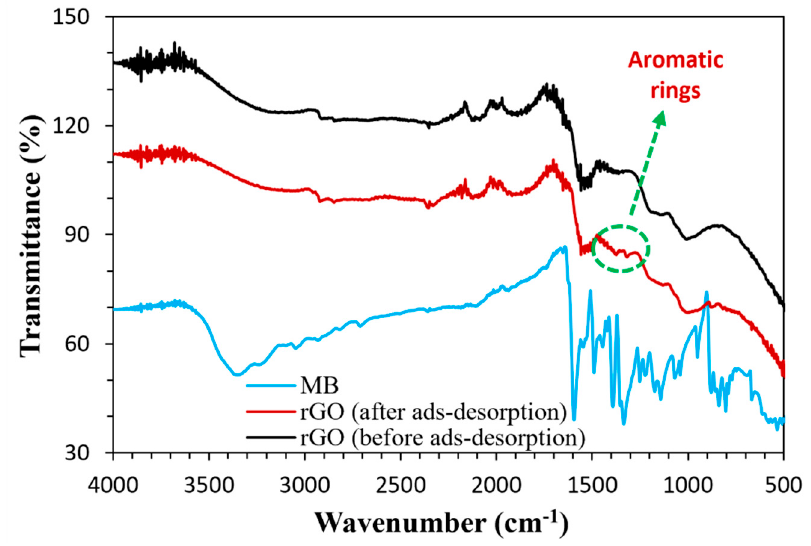
Figure 17. Recycling performance of rGO for capturing of MB up to 4 cycles ( C MB0 = 20 mg/L, W rGO = 8 mg, V = 100 mL, T = 298 K).